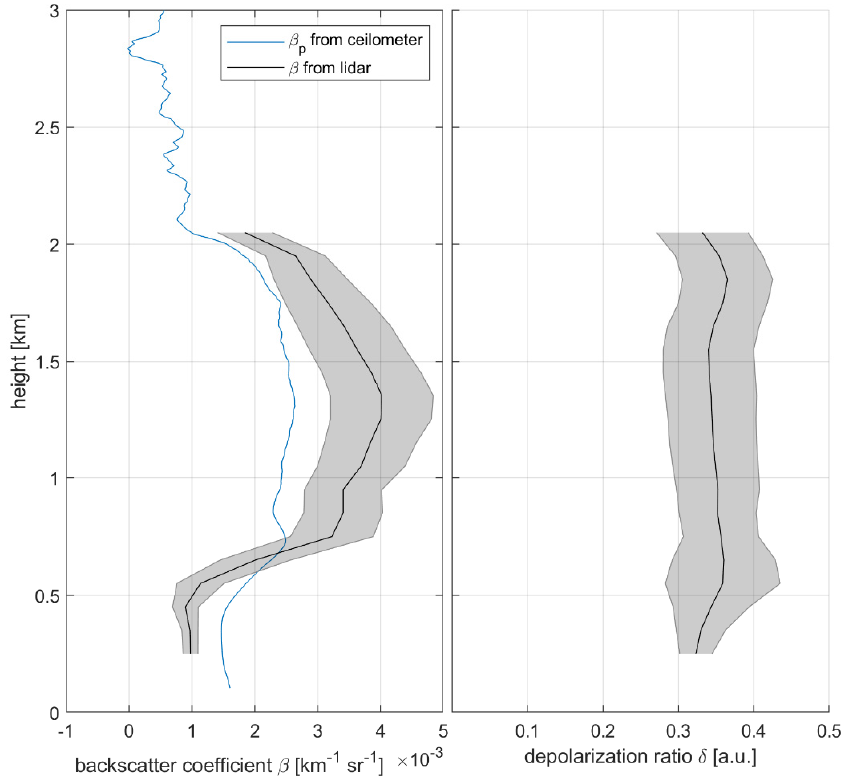
Figure 8. Left panel: 30-min-average (solid black line) of lidar β [km − 1 sr − 1 ] and ceilometer (blue line) retrieved β p [km − 1 sr − 1 ] at 21:20 on 14 June, 2019, Reykjavik. The shaded area shows the standard deviation. Right panel: lidar δ from the same period. The lidar data is filtered by CNR.